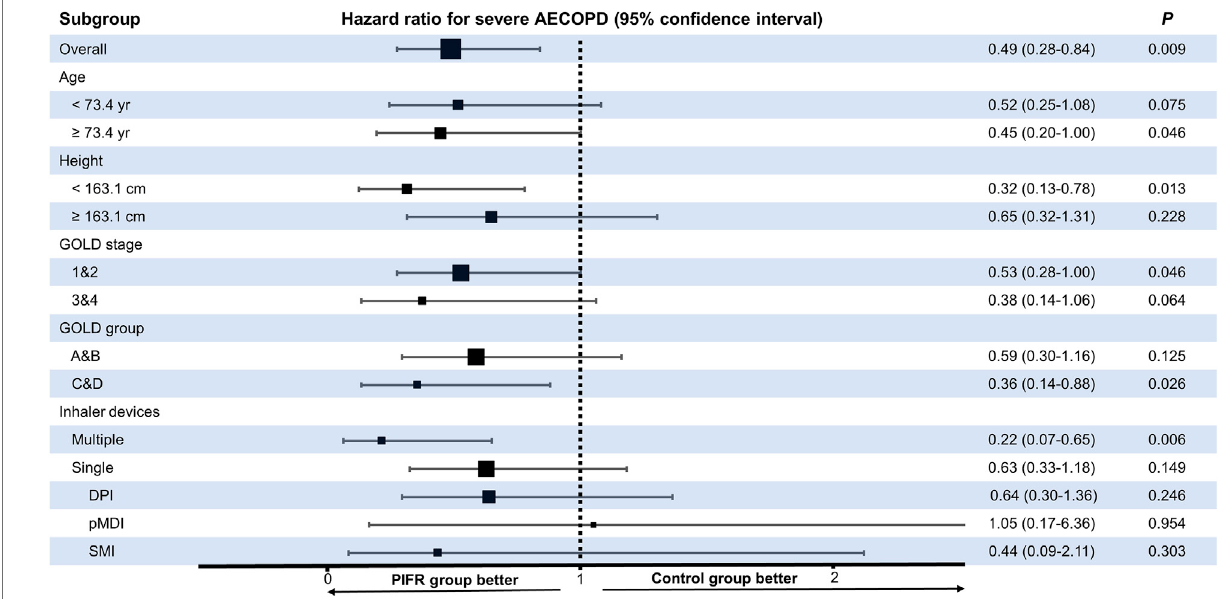
FIGURE5| Forrestplotpertainingtothehazardratiosofthetimeintervaltothe fi rstepisodeofsevereacuteexacerbationofchronicobstructivepulmonarydisease (AECOPD) among thepatients in thePIFRand controlgroups, strati fi edbysubgroups.GOLD:Global Initiative forChronicObstructive LungDisease;pMDI:pressurized metered dose inhaler; SMI: soft mist inhaler; DPI: dry powder inhaler.